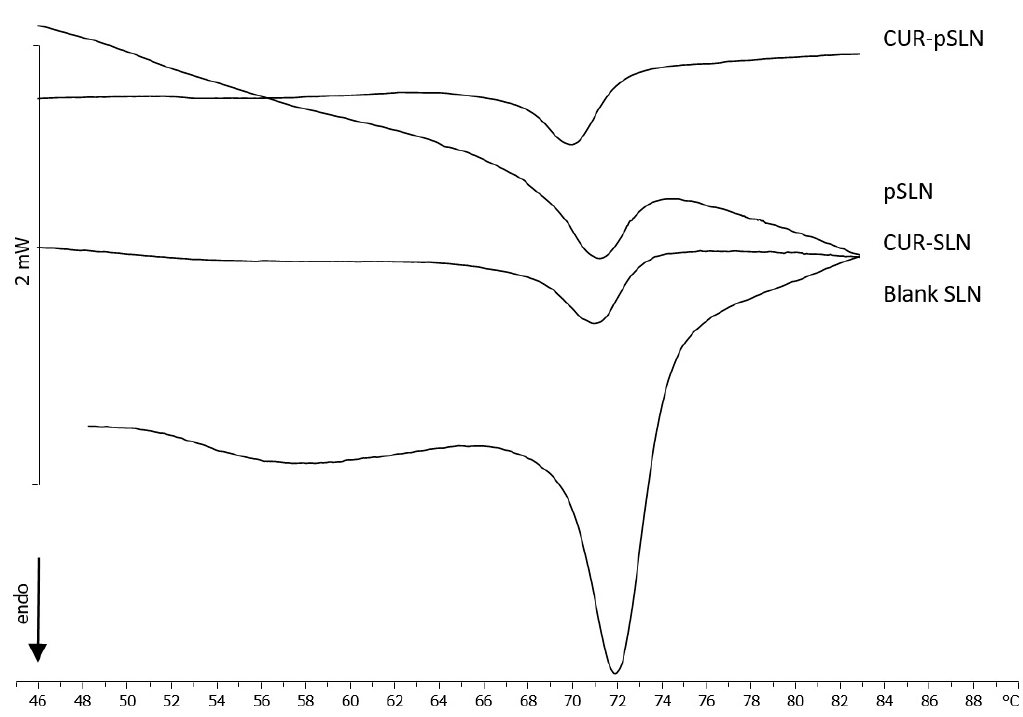
Figure 7. Calorimetric curves, in heating mode, of blank SLNs, CUR-SLNs, blank pSLNs, and CUR-